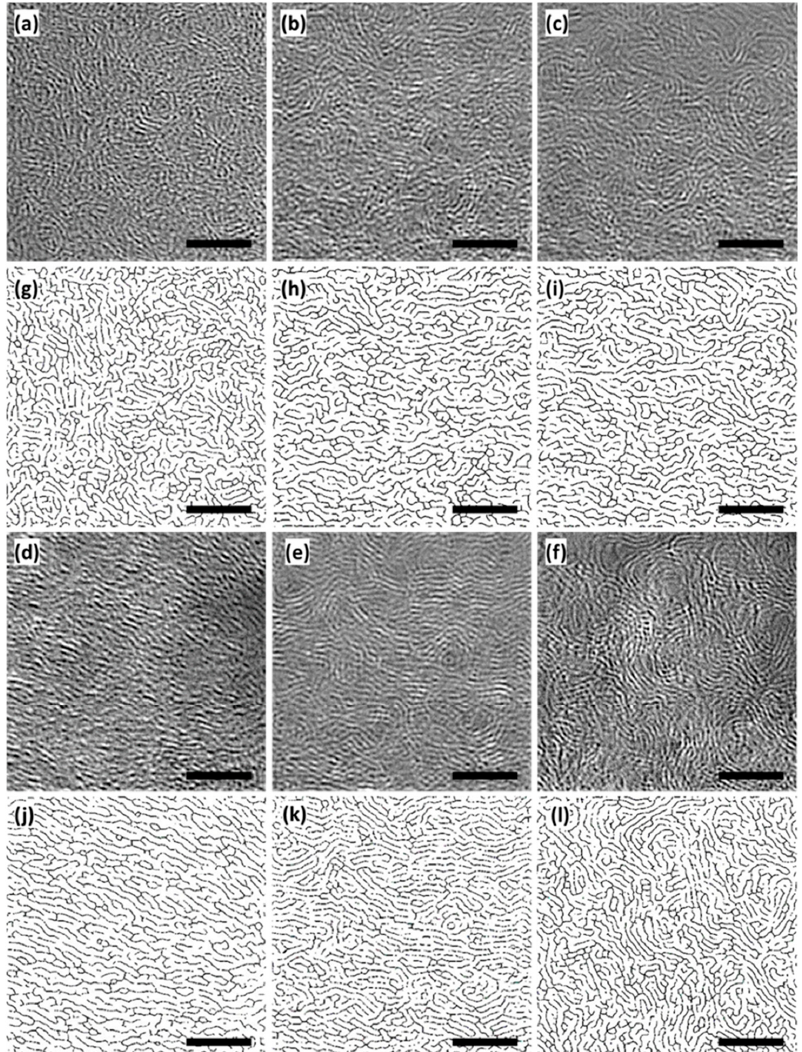
Figure 5. High-resolution transmission electron microscopy (HRTEM) analysis of KL-X samples: the negative HRTEM images of ( a ) KL-500; ( b ) KL-600; ( c ) KL-700; ( d ) KL-800; ( e ) KL-900; ( f ) KL-1000 showing the morphologies of nano-graphene layers; and ( g – l ) are the corresponding skeletonized HRTEM images showing the arrangements and lateral size L a of nano-graphene layers. The size bars represent 5 nm.